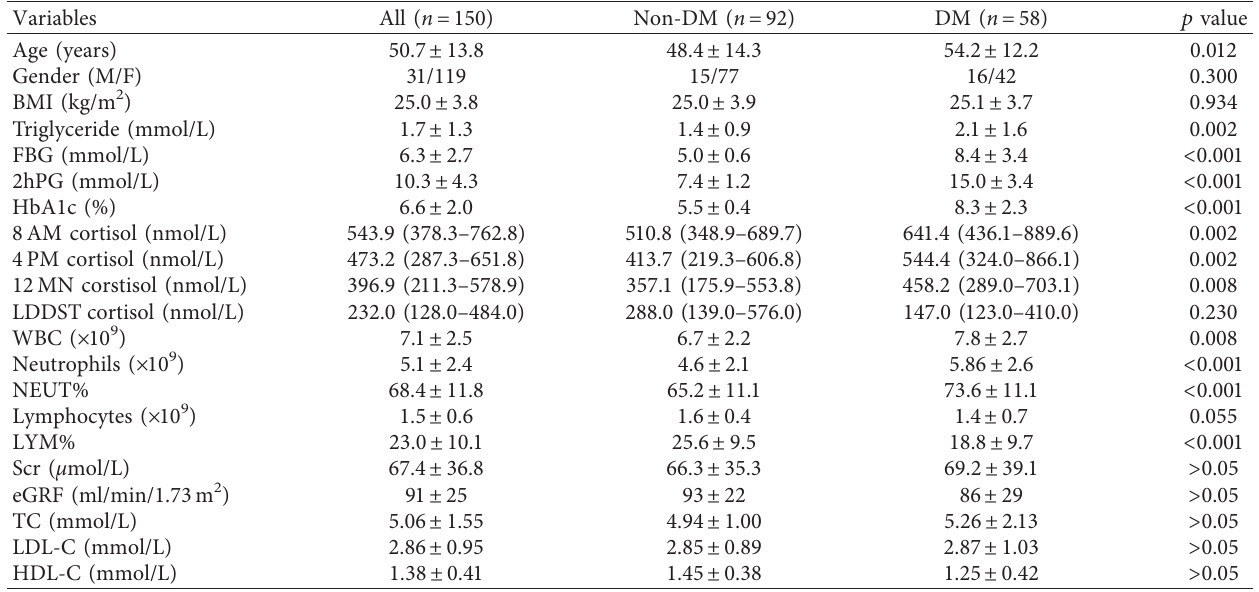
Table 1: General characteristics of Cushing’s syndrome patients with or without